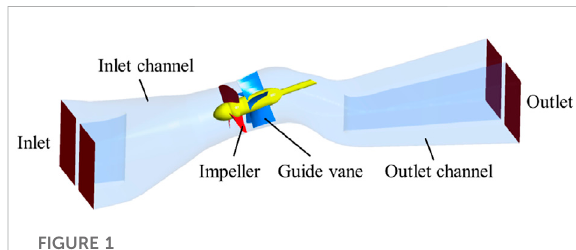
FIGURE 1 Three-dimensional model of slanted axial- fl ow pump.